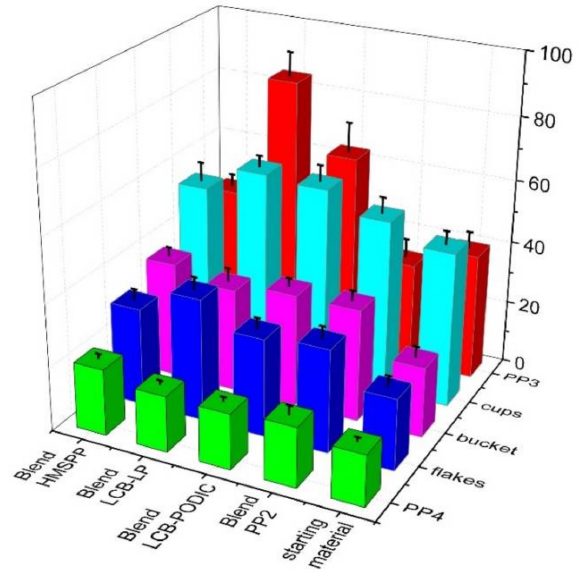
Figure 9. Tensile impact test of all